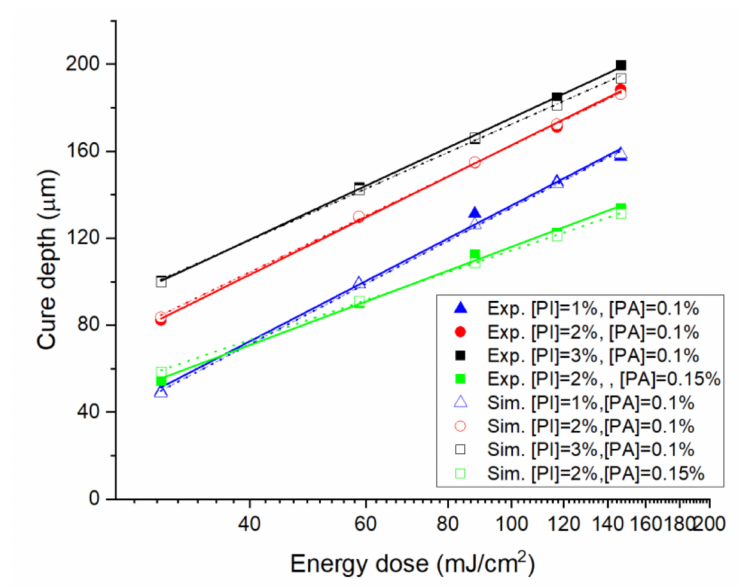
Figure 6. Comparison of curing depth between experiment and simulation. x -axis represents energy dosage in log scale and y -axis is curing depth in linear scale.